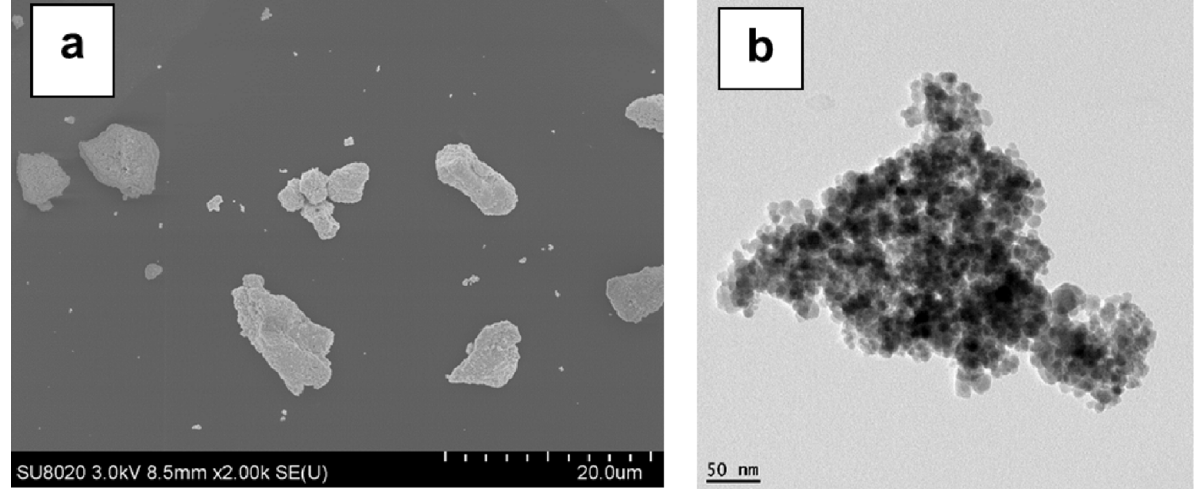
Figure 9. ( a , b ) SEM ( a ) and TEM ( b ) images of magnetite NPs revealing that the primary nanoparticles are agglomerates.